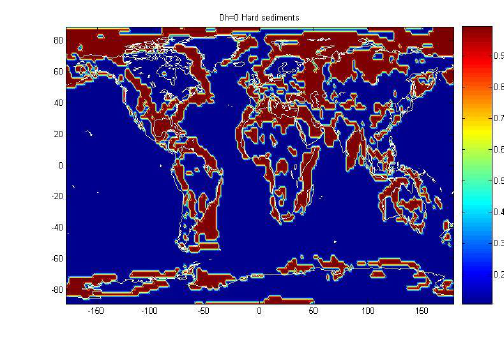
Figure 2. Global distribution of hard sediments in CRUST 2.0 database (purple color).